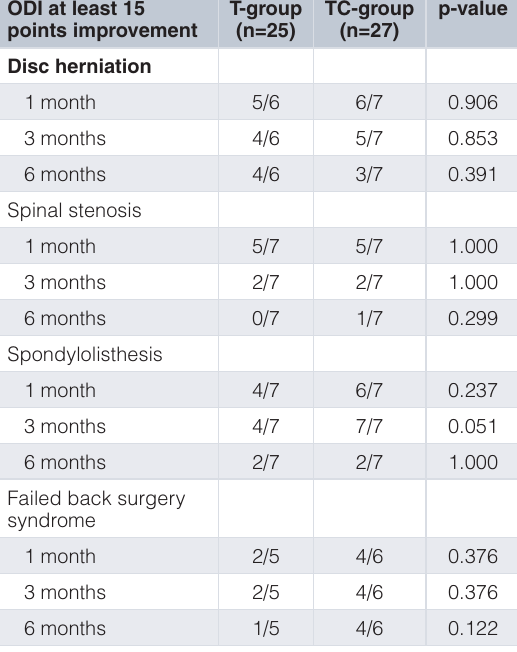
Figshare: Information of abbreviation data set. https://doi. org/10.6084/m9.figshare.12361499.v1 37